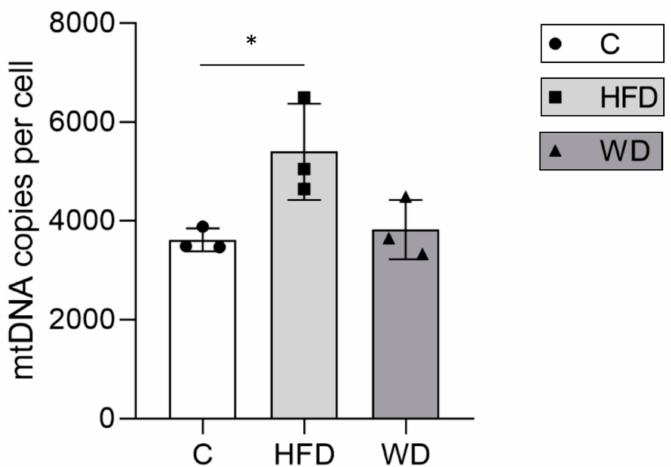
Figure 3. Impact of diet on mitochondrial DNA content of mouse liver. Absolute mtDNA content per cell was measured in liver of mice fed on a standard chow (C, n = 3, circle and white bar), high-fat (HFD, n = 3, square and light grey bar), and Western (WD, n = 3, triangle and dark grey bar) diets at 16 weeks. mtDNA content per cell is plotted for individual animals with error bars for mean ± SD. Significance indicated by * p = 0.0372 using two-tail unpaired t-test on log-transformed